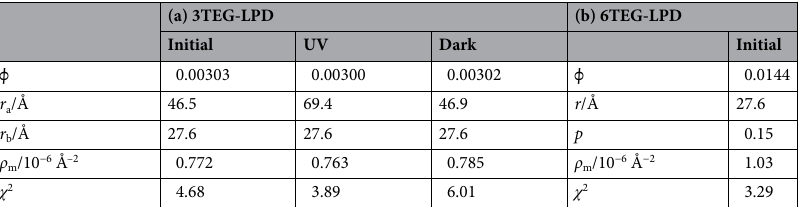
Table 1. SANS profiles with fitting results, after UV irradiation and standing in the dark, of 10 mM 3TEG- LPD (a) and 6TEG-LPD (b) solutions. Prolate ellipsoids for 3TEG-LPD and spheres with a Schultz size distribution for 6TEG-LPD were modeled. is the volume fraction, and r a or r b is the long or short radius of ellipsoids, respectively. r and p are the mean radius and polydispersity of the radius, respectively. ρ m is the ϕ scattering length density of the micelle. Here, the scattering length density of the micelle or solvent ( ρ s ) was fixed at 6.30 × 10 −6 Å −2 for D 2 O. χ 2 is the chi-square value for